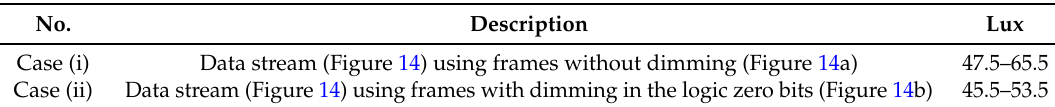
Table 2. Illumination Level of the Frame Stream Using Different Levels of Dimming.